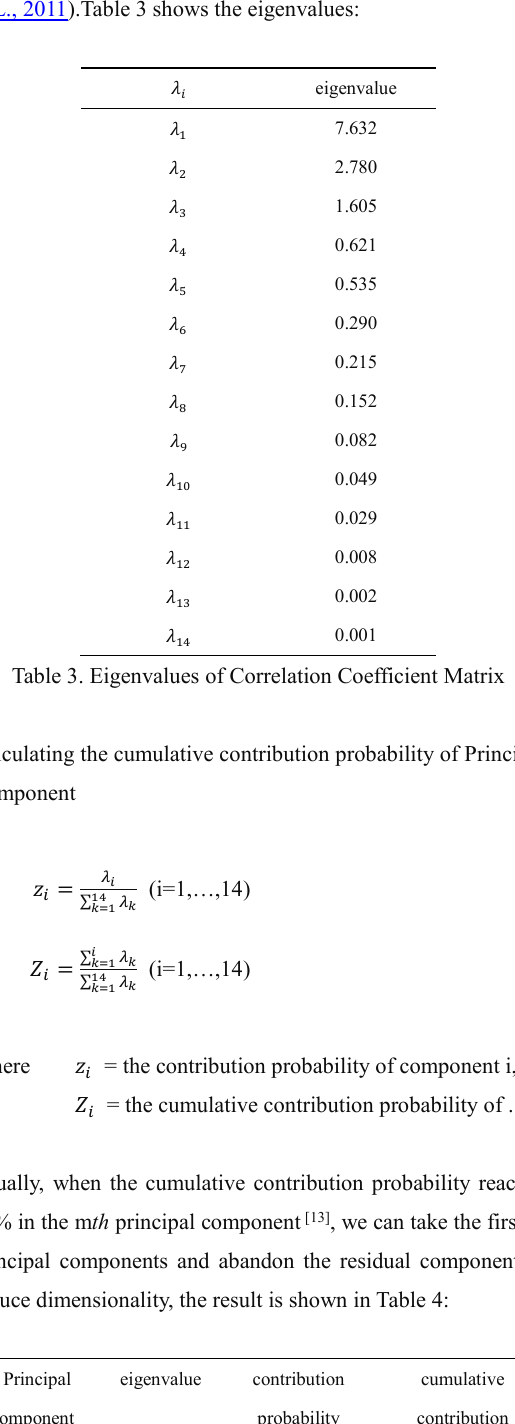
Table 5. Variance of determining factors of user